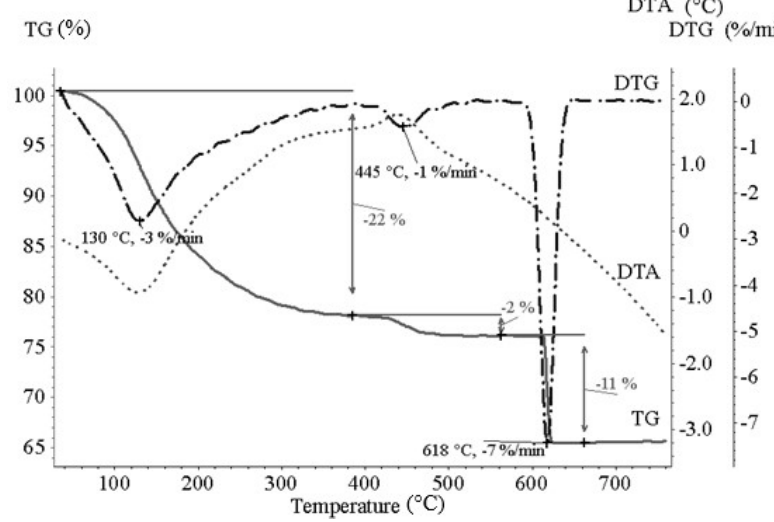
Figure 7. Thermogravimetric analysis (TGA) of EC solid product prepared from leachate of EAFS slag.